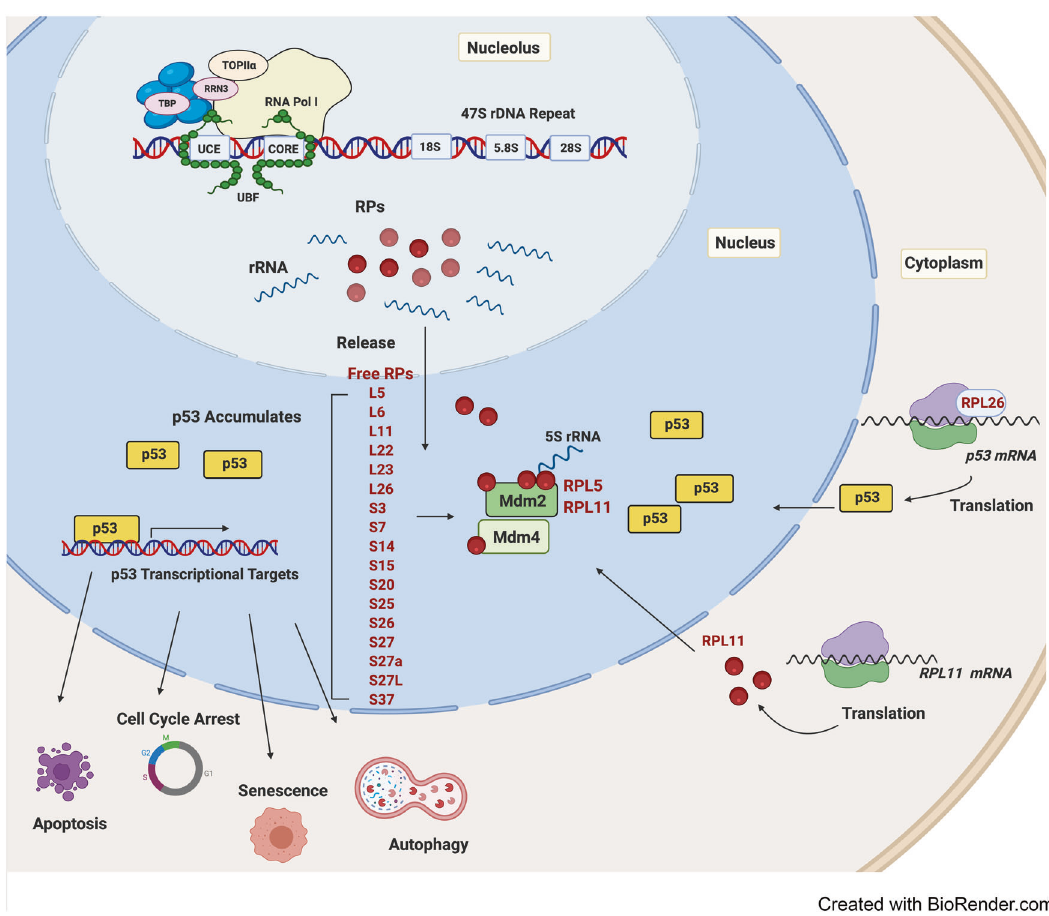
(Mdm2) and its homolog Mdm4, leading to ubiquitination and degradation of p53. When ribosome biogenesis is disrupted at the level of rRNA synthesis, processing or ribosome assembly, free ribosomal proteins (RPs) (primarily RPL5 and RPL11 and RPL23) and the 5S rRNA are released from the nucleolus to the nucleoplasm where they bind and sequester Mdm2/Mdm4. This in turn prevents the poly-ubiquitination and proteasome-mediated degradation of p53, thereby mediating its stabilization. The RPs (indicated) have been shown to regulate the Mdm2/p53 axis through various mechanisms including binding Mdm2 and its homolog and binding partner Mdm4. Additional mechanisms of nucleolar stress response include ribosome stress-mediated increase in RPL11 mRNA translation, which leads to enhanced interaction between RPL11 and Mdm2 and subsequent accumulation of p53. Following nucleolar stress, p53 can also be activated by RPL26 binding to p53 mRNA and enhancing its translation. Upon activation, p53 transactivates several downstream targets, leading to cell cycle